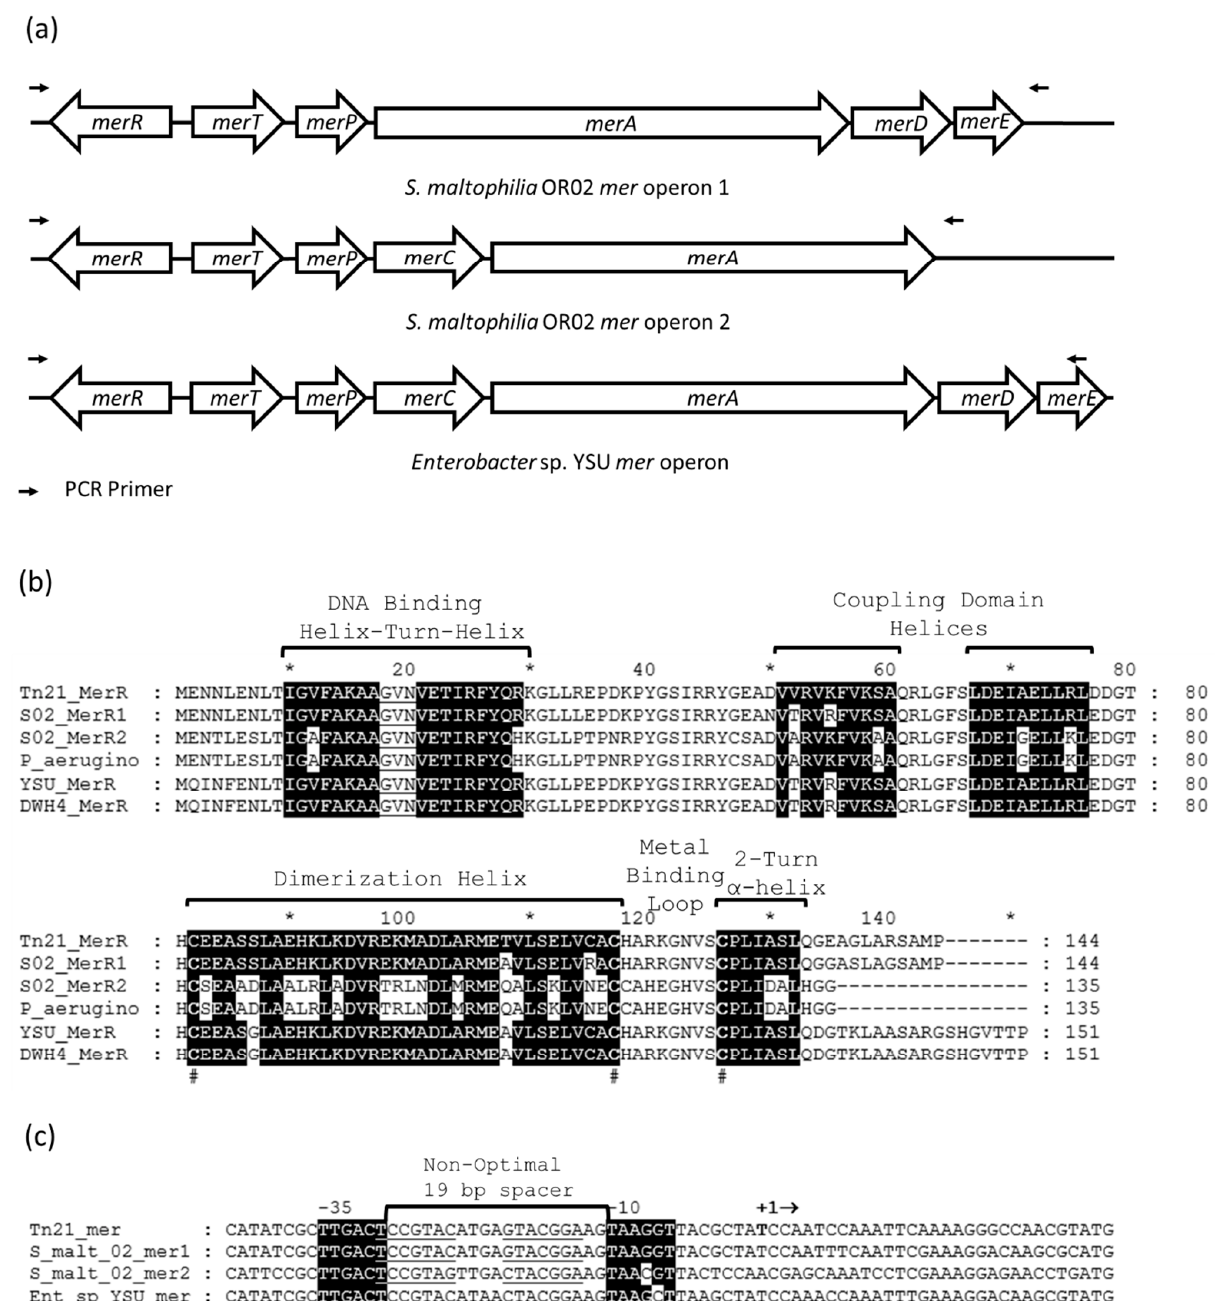
Figure 2. The S. maltophilia 02 and Enterobacter sp. YSU mercury resistance ( mer ) operons and MerR protein activa- tor/repressor switches. ( a ) Mercury resistance operons in S. maltophilia 02 and Enterobacter sp. YSU. The genes between the primers were copied by polymerase chain reaction (PCR), cloned and tested for the Hg(II) resistance phenotype. ( b ) Pre- diction of the S. maltophilia 02 and Enterobacter sp. YSU MerR secondary structure using the Tn 21 , Pseudomonas aeruginosa , and Enterobacter cloacae plasmid DWH4 MerR amino acid residue primary sequences. Each contain a DNA binding domain, a coupling domain and a metal binding domain. The # below the sequences designates conserved cysteine amino acid residues which bind to Hg(II). The * and numbers above the MerR primary sequences denote the position of every 10 amino acid residues. ( c ) Prediction of the S. maltophilia 02 and Enterobacter sp. YSU mer promoter regions using the Tn 21 mer promoter. All appear to contain non-optimal 19-bp spacers and MerR binding regions between the -10 and -35 region. Identical nucleotides in the -10 and -35 regions are highlighted in black. Transcription begins at the nucleotide base (bold) below + in +1. The first three base pairs, CAT, on the far left marks the beginning of MerR translation. The last three base pairs, ATG, on the far right marks the beginning of MerT translation.